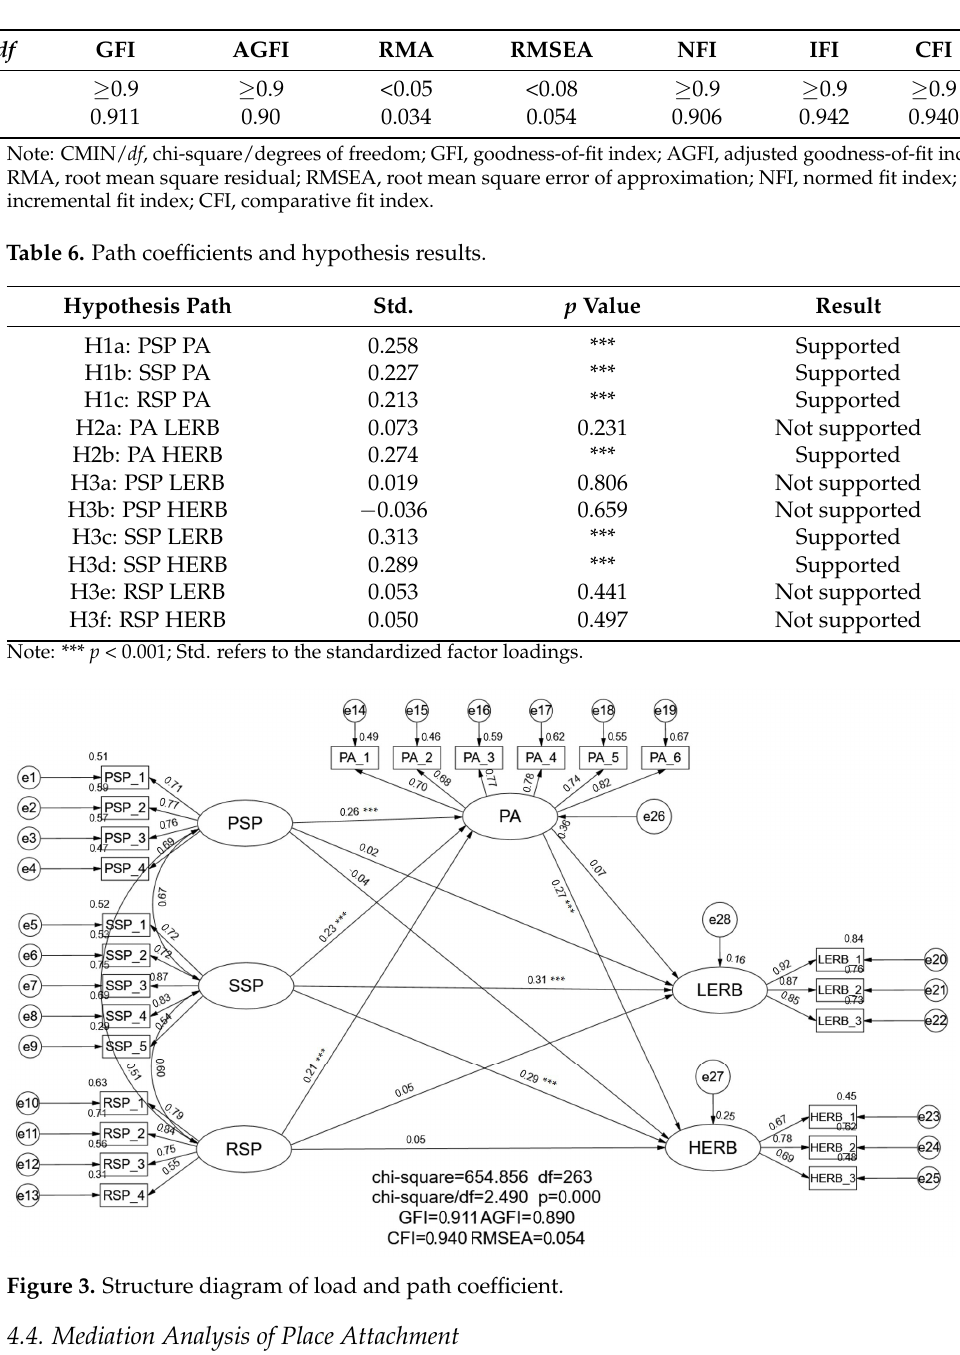
Table 7. Results of the mediation effect.